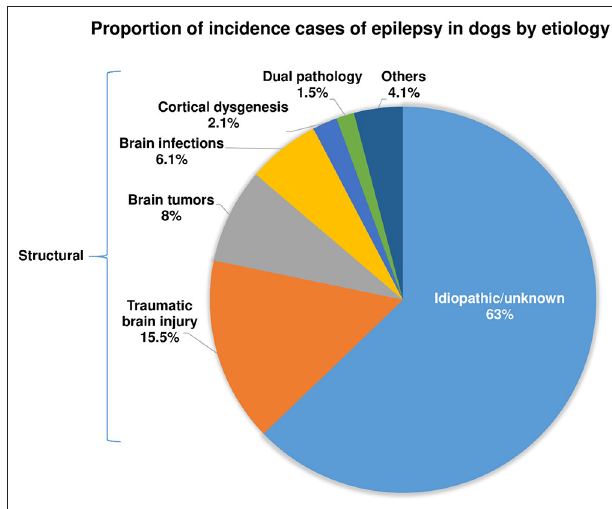
FIGURE 1 | Presumed causes of recurrent epileptic seizures in dogs with epilepsy. See Steinmetz et al. ( 38) and text for further